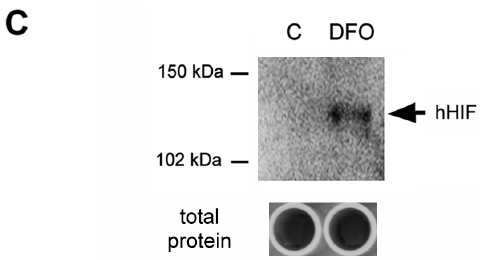
Figure 2. Validation of DFO effect on HIF-1 α in NMB cells. ( A ) Cells were treated without or with DFO for 24 h. Dead cells were removed. The surviving/attached cells were harvested. RNAs were extracted from cells treated without (control; C) or with DFO for 24 h. Semi-quantitative RT-PCR was performed using a pair of human HIF-1 α (hHIF) specific primers. A pair of human β -actin specific primers, as an internal standard, was also included in PCR reaction (added at the cycle 19) for normalization use; ( B ) the normalized hHIF-1 α message from the non-DFO treated control was designated as 100%. Data is presented as mean ± S.E.M. Experiments were repeated eight times. “*” indicates p < 0.01. (Student t -test); ( C ) Western blot analysis was performed using an anti-hHIF-1 α antibody with the same amount of nuclear extracts from control (C) or DFO treated cells (DFO). The amount of total proteins for each sample was shown in the panel below using colormetric Lowry assay. The hHIF-1 α signal (indicated by an arrow) was detected only in DFO treated cells, demonstrating its nuclear translocation.